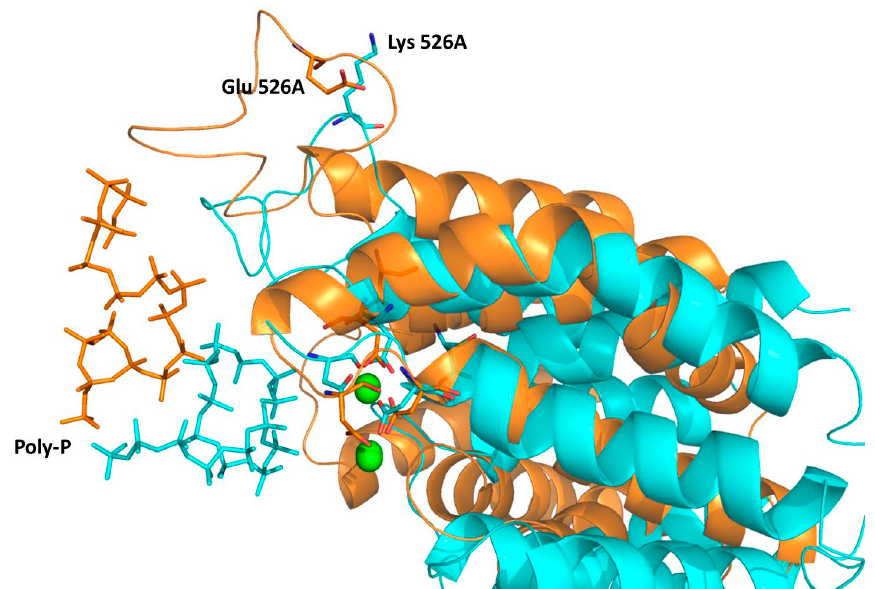
Figure 7. Overlapping of representative snapshots of the average structures in the last 500 ps of the MD simulations obtained with the wild type (gold) and 1H2 mutant (blue) complexed with the poly-P. Magnesium cations are represented as green balls. Poly-P docked in the L -domain of the 1H2 mutant (blue) and wild-type (gold) DHAK are shown as sticks. The Lys that substitutes to the Glu in position 526 in the mutant, and aspartate residues that interact with ATP in the wild-type DHAK, are also shown as sticks.